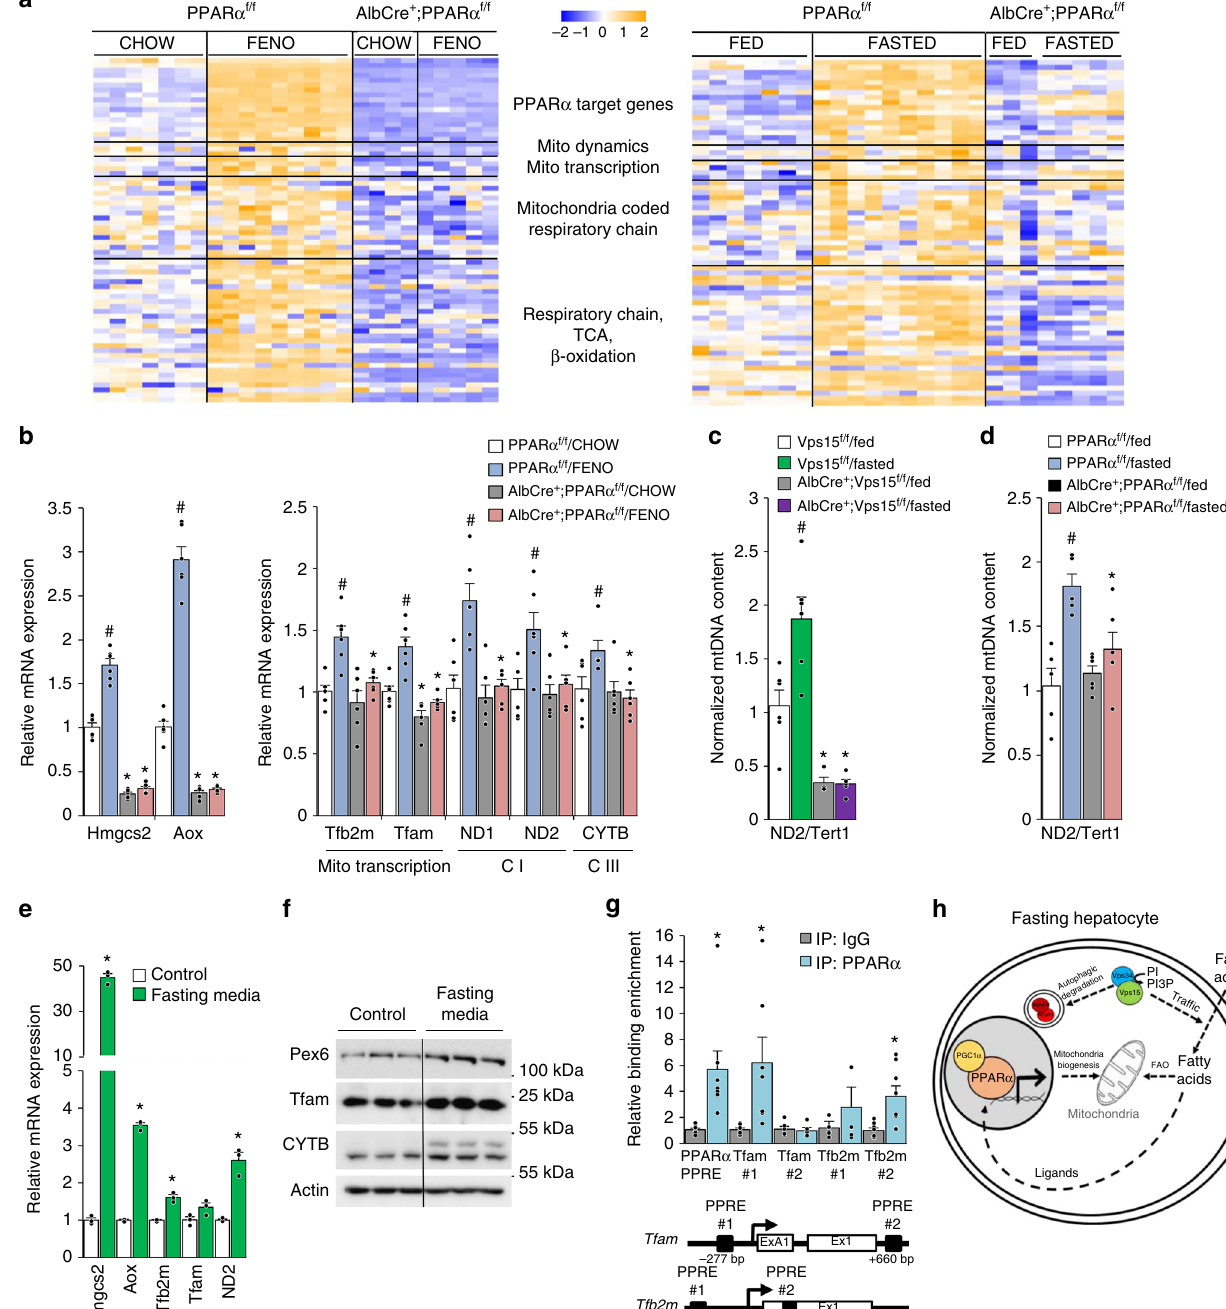
mitochondrial turnover and mitochondrial biogenesis in hepatic Vps15 mutant. The positive function of PPAR α in mitochondrial biogenesis might be restricted to hepatocytes. In the heart, PPAR α activation inhibits respiratory chain gene expression, while in skeletal muscles, it promotes the metabolic transition towards glycolytic fi bres which are characterised by a lower mitochondrial activity 60,61 . In skeletal muscles, deletion of PPAR α reduces FAO but increases the number of oxidative fi bres 61,62 . Mitochondrial biogenesis in the heart and skeletal muscles is induced by a transcriptional complex of ERR and PGC1 α 60 . The molecular mechanisms of these tissue-speci fi